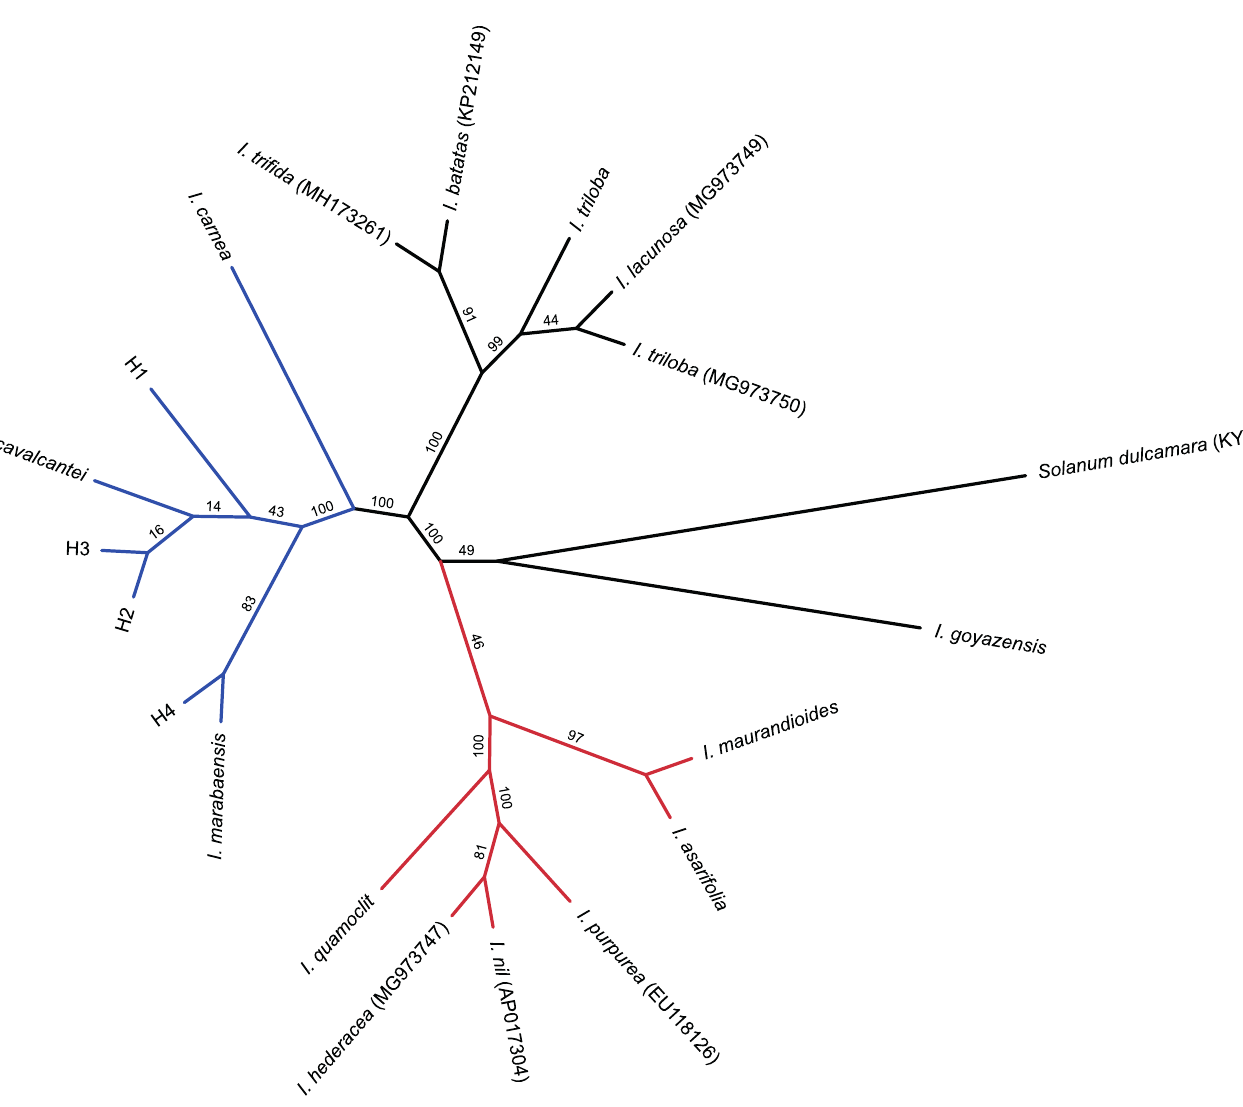
Fig 4. Phylogenetic relationships among Ipomoea species. Unrooted ML phylogenetic tree of the 12 Ipomoea sequenced plastomes, plus five Ipomoea plastomes previously available in public databases and one outgroup from Solanales ( Solanum dulcamara ) using RAxML with the GTR+G model and rapid bootstrap with 1,000 replicates, based on a concatenated matrix of 13 genes. The cavalcantei-marabaensis group is highlighted in blue and the quamoclit-asarifolia-maurandioides in brown.